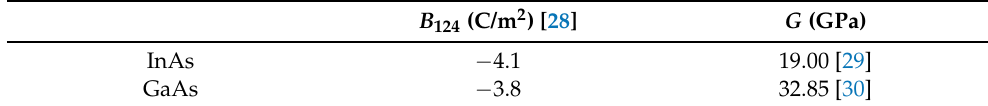
Table 1. Parameter values used in k · p calculation and in Equation